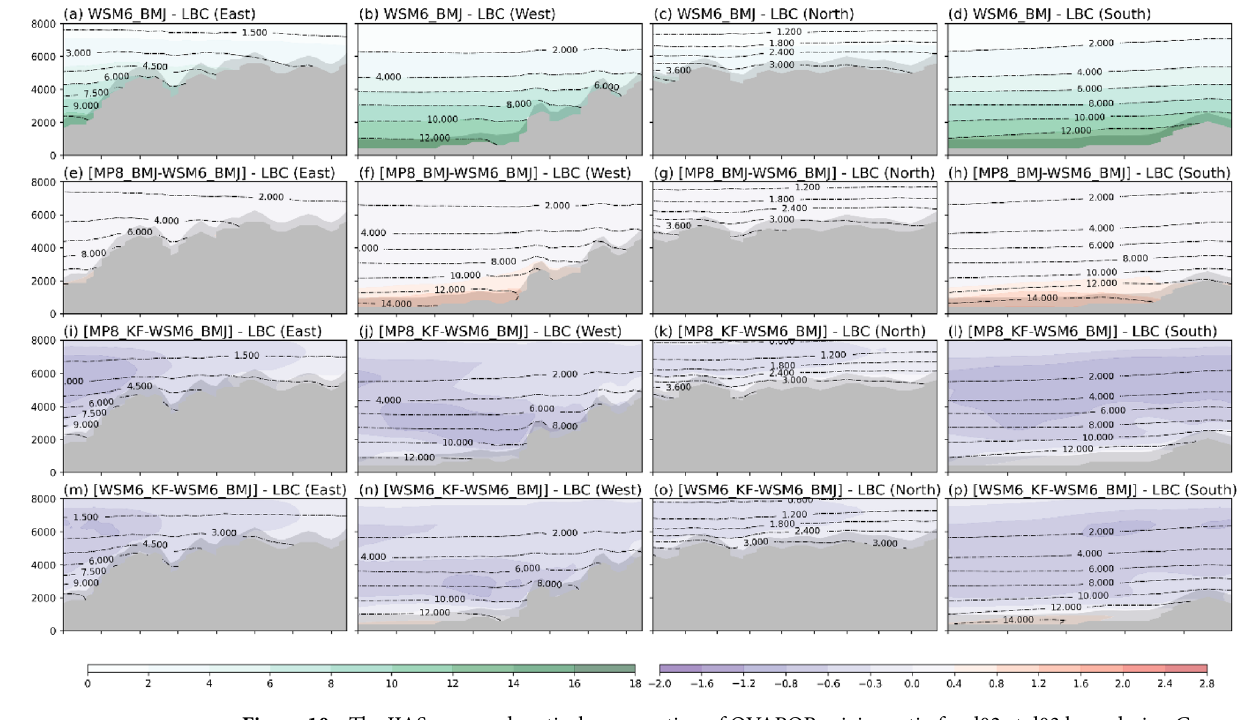
Figure 10. The JJAS-averaged vertical cross section of QVAPOR mixing ratio for d02 at d03 boundaries. Gray shaded area shows mountains. ( a – d ) shows actual average mixing ratio for WSM6_BMJ at east ( a ), west ( b ), north ( c ), and south ( d ) boundaries. Further, mixing ratio is shown for MP8_BMJ–WSM6_BMJ ( e – h ), MP8_ KF–WSM6_BMJ ( i – l ), and WSM6_KF–WSM6_BMJ ( m – p ) for vertical cross section of east ( e , i , m ), west ( f , j , n ), north ( g , k , o ), and south ( h , l , p ) boundaries.